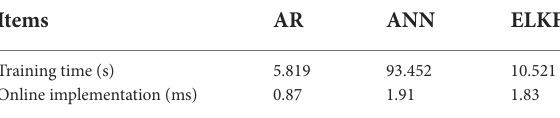
TABLE 3 Comparison of AR, ANN, and ELKF computational loads.